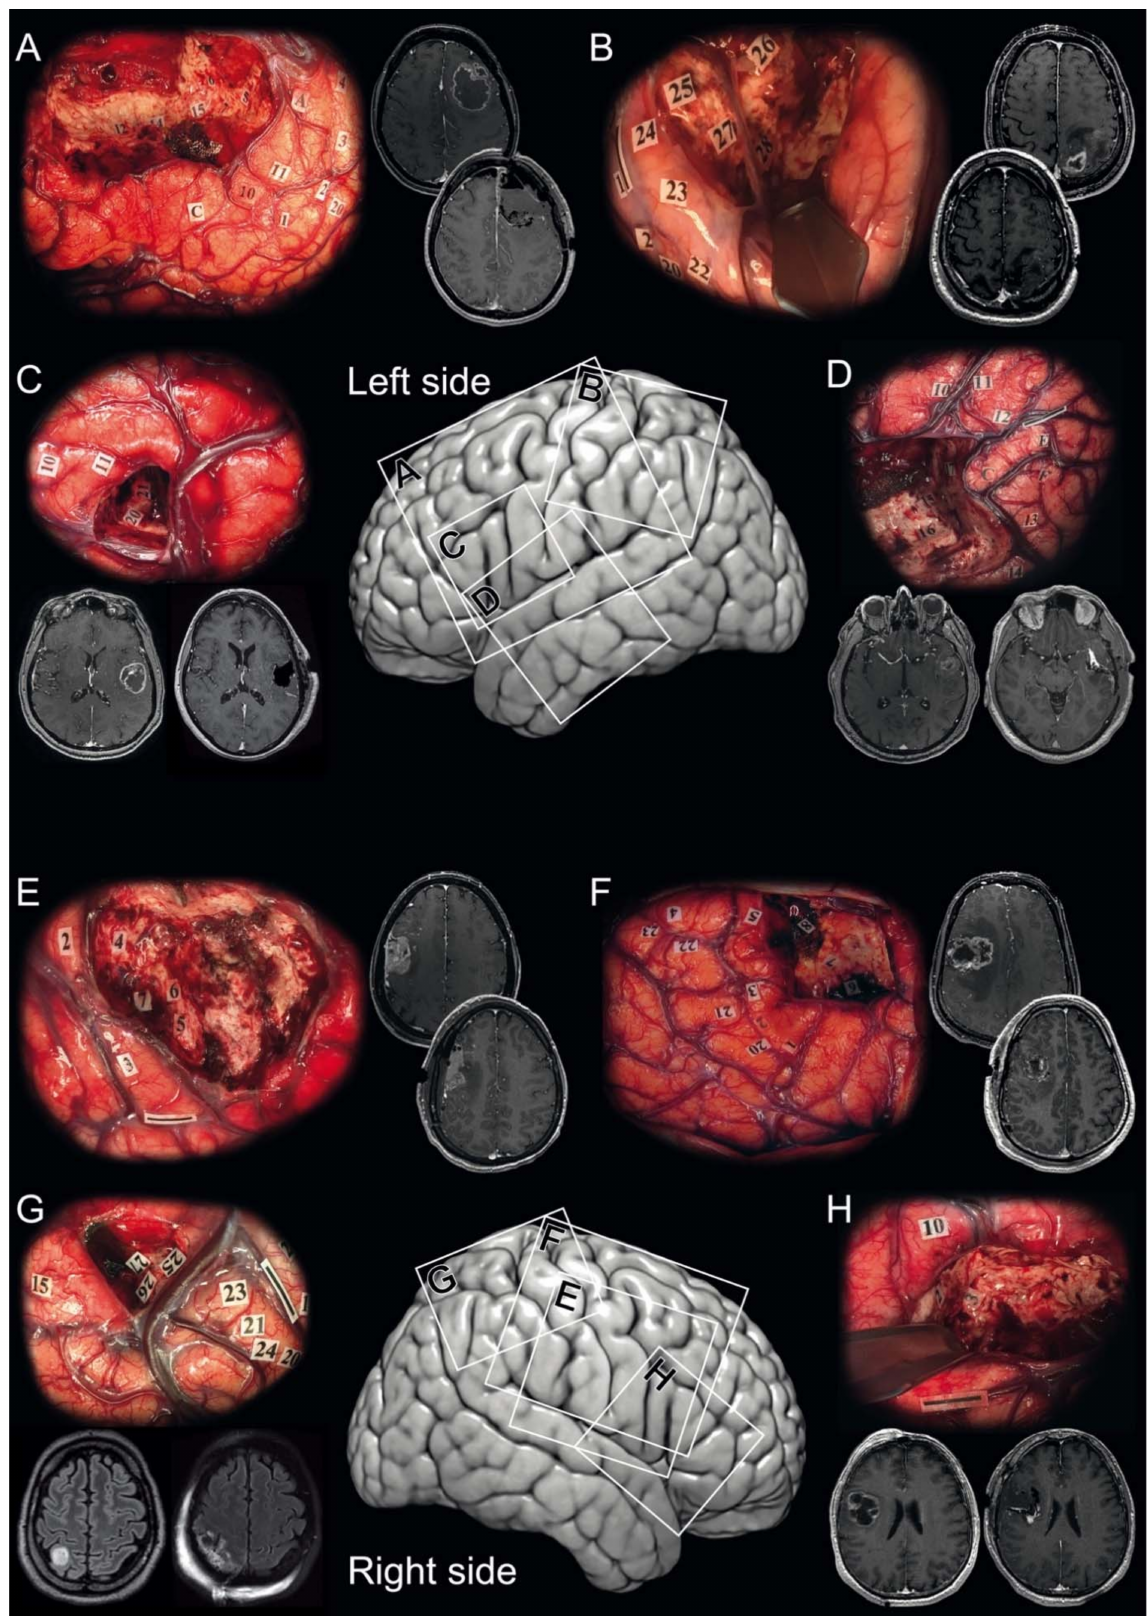
Figure 1. Illustrative cases. Illustrative cases of isocitrate dehydrogenase ( IDH )-wildtype glioblastoma awake resection using direct cortico-subcortical electric stimulations to define functional boundaries. Intraoperative photographs